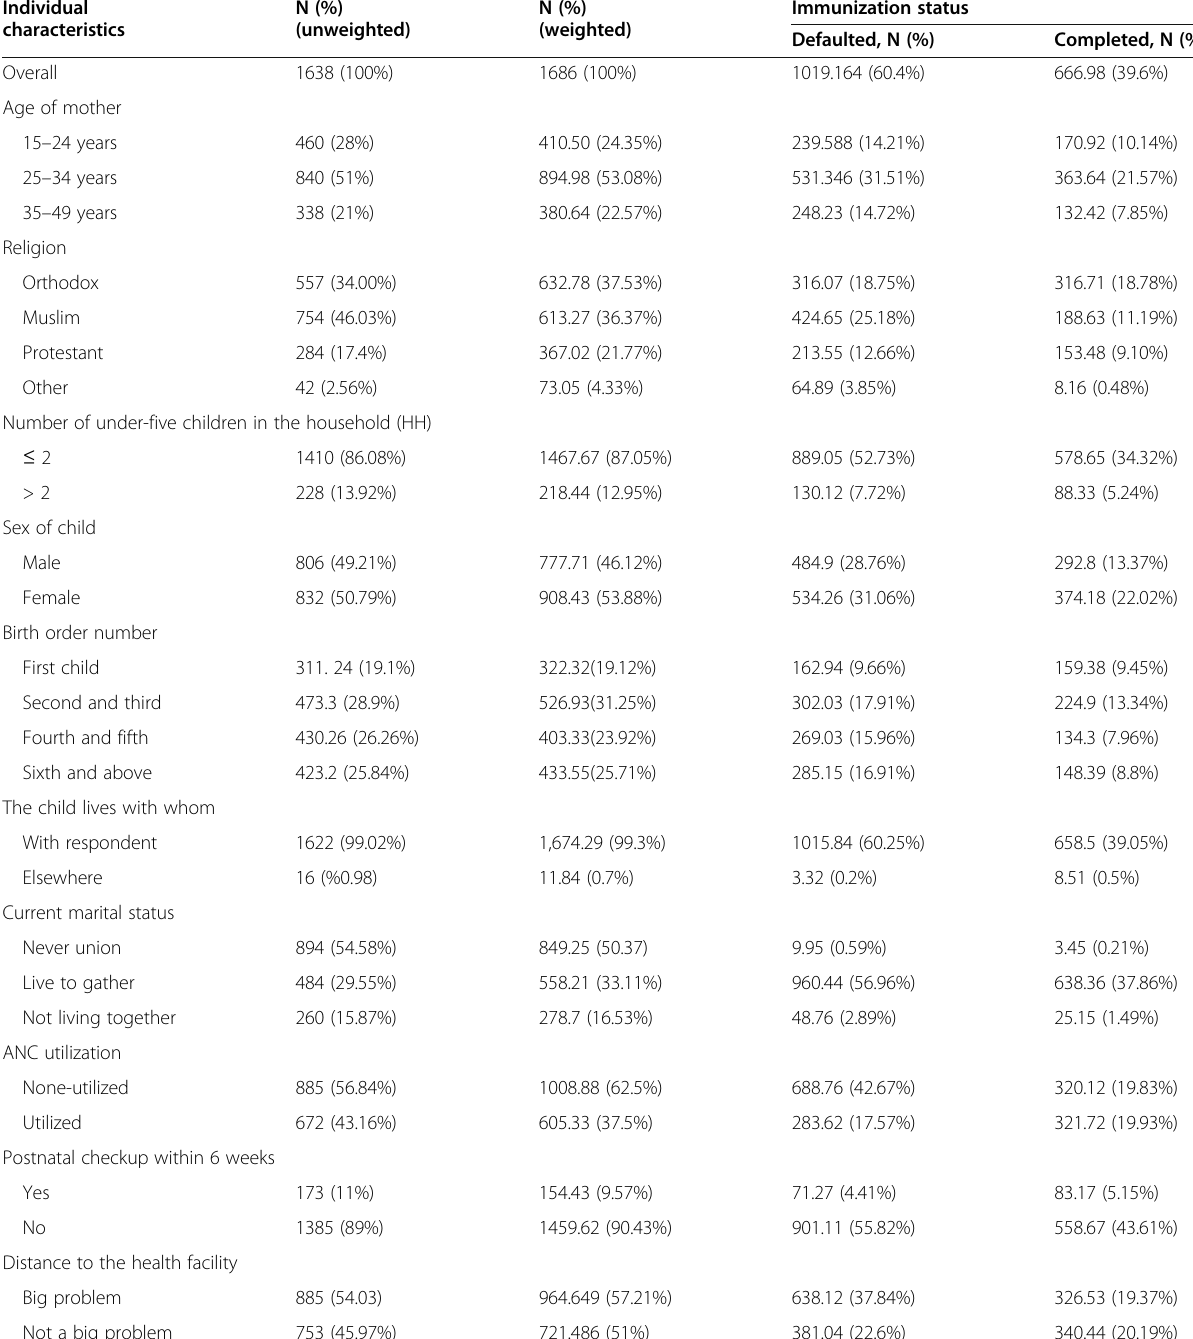
Table 1 Background characteristics of individuals among children aged from 12 to 23 months in EDHS 2016 (unweighted n = 1638 and weighted n =